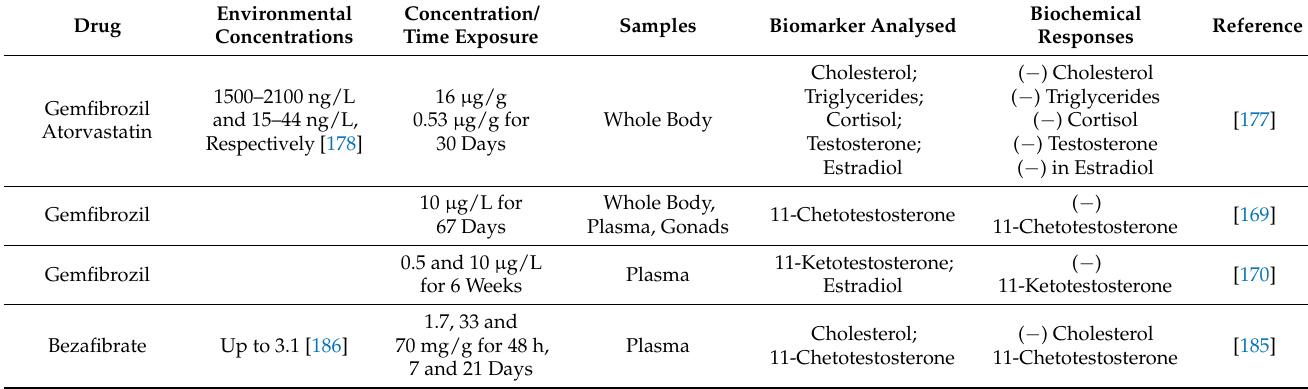
Table 3. Biochemical responses in zebrafish exposed to antidyslipidemic